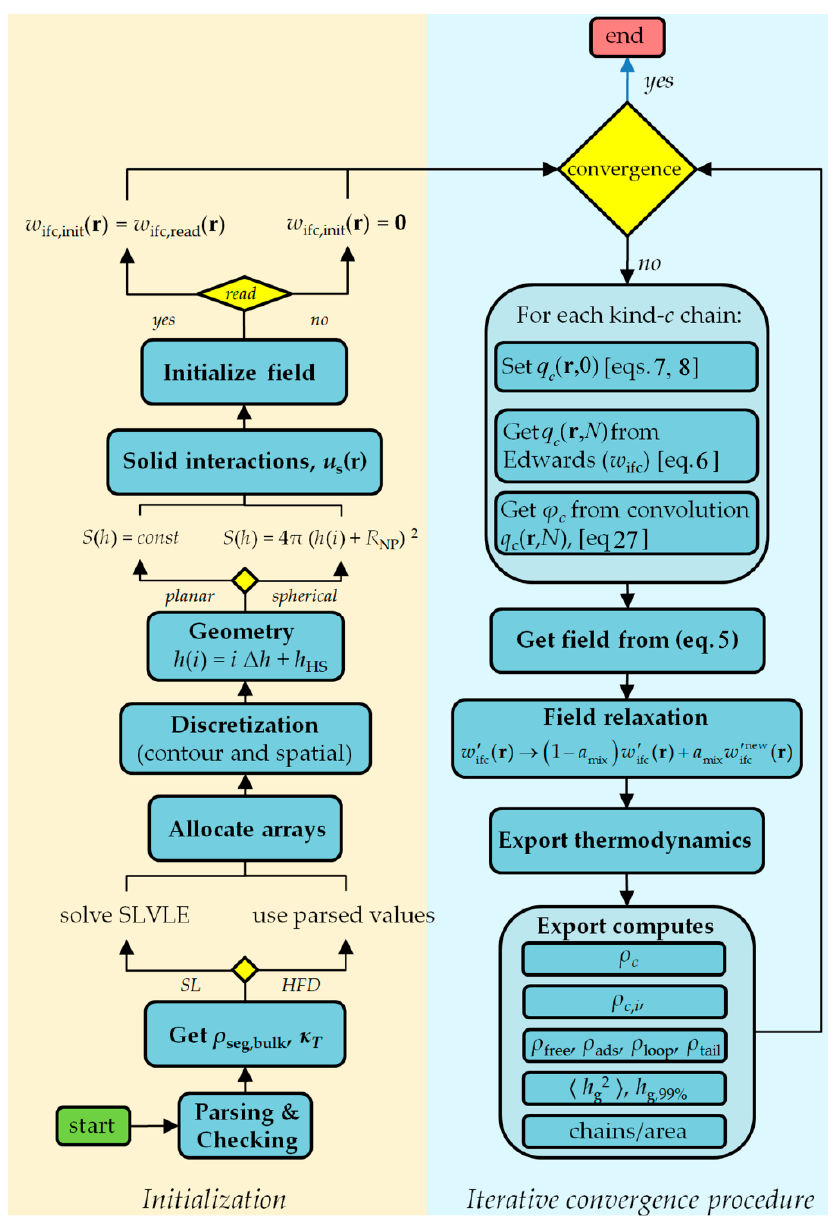
Figure 5. Flow diagram of RuSseL.